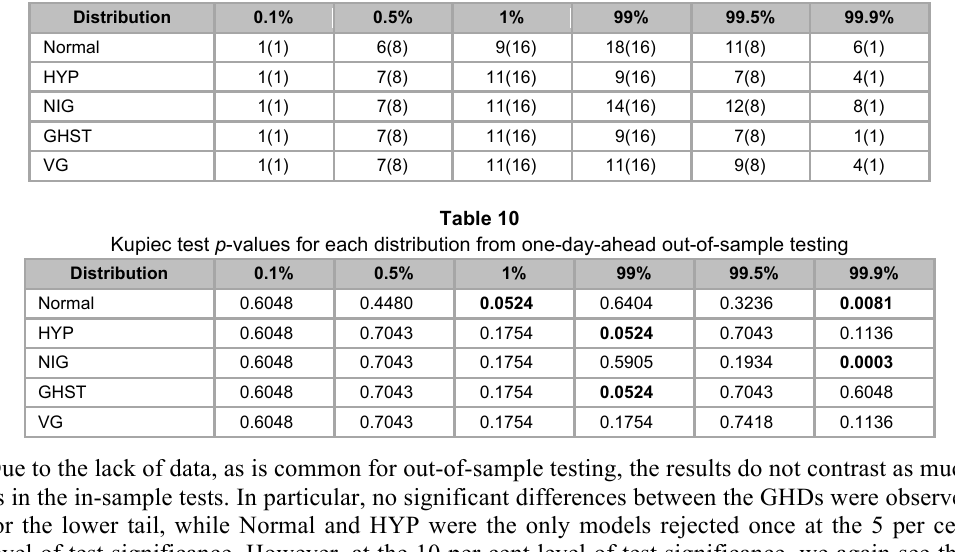
Actual and expected (in brackets) number of violations of VaR estimates for each model from one-day-ahead out-of-sample testing